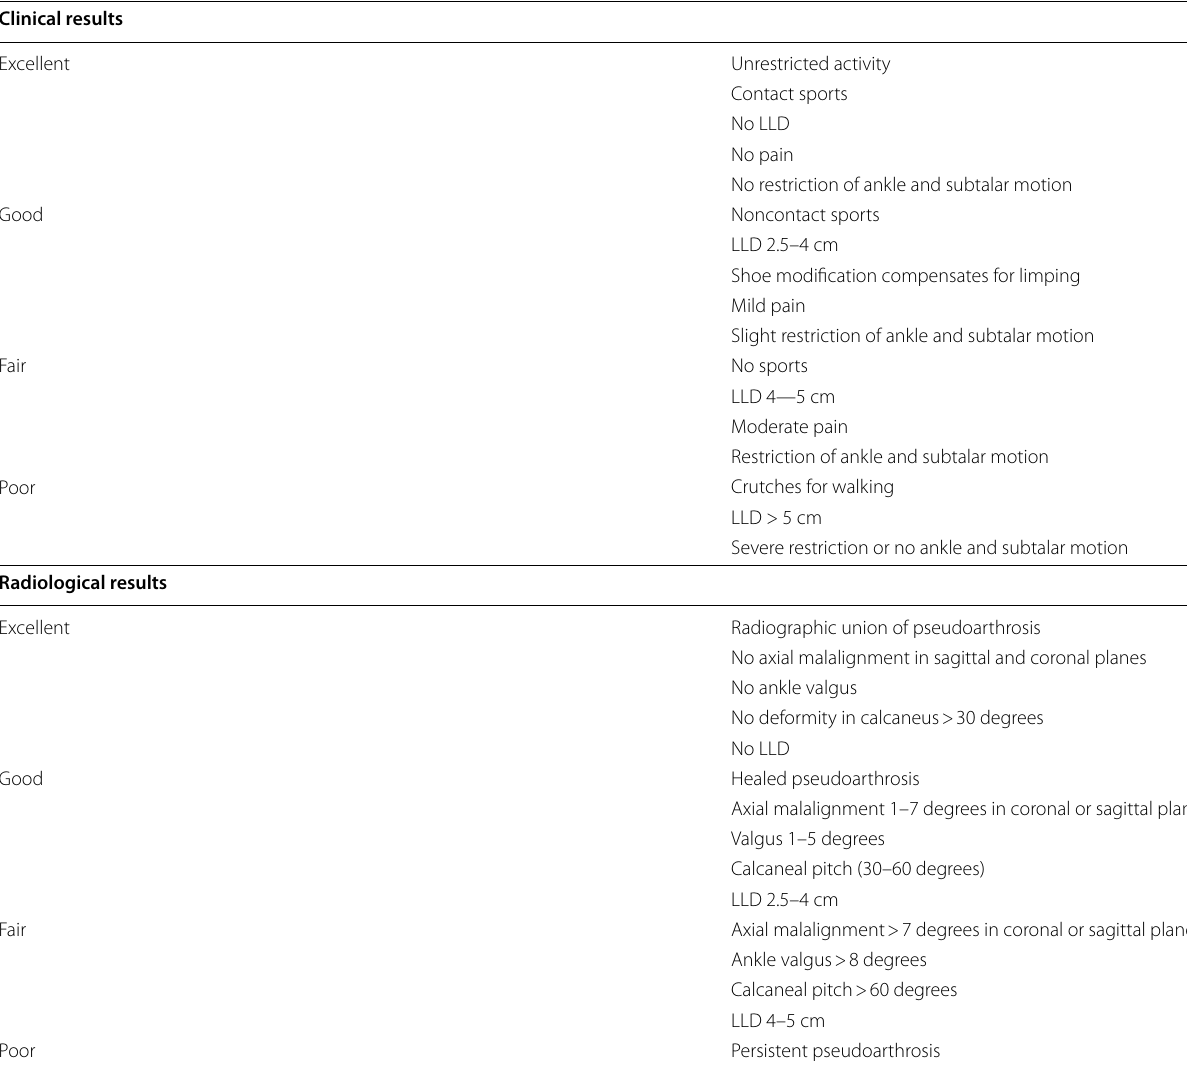
Table 1 Classification of clinical and radiological results according to the study by Inan et al. [22]